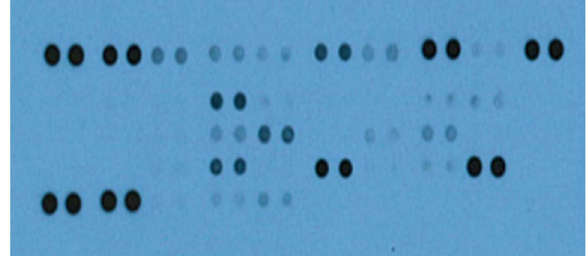
Figure 1. A representative image of the various biomarkers detected in the sera of IBS patients and healthy volunteers. Each pair of horizontal blots (bands) represent a different biomarker present in the serum, whereas the intensities of the blots characterize the amount of the respective biomarker. Sera (250 m L) from 60 IBS patients (44 idiopathic IBS and 16 post-infectious IBS) and 40